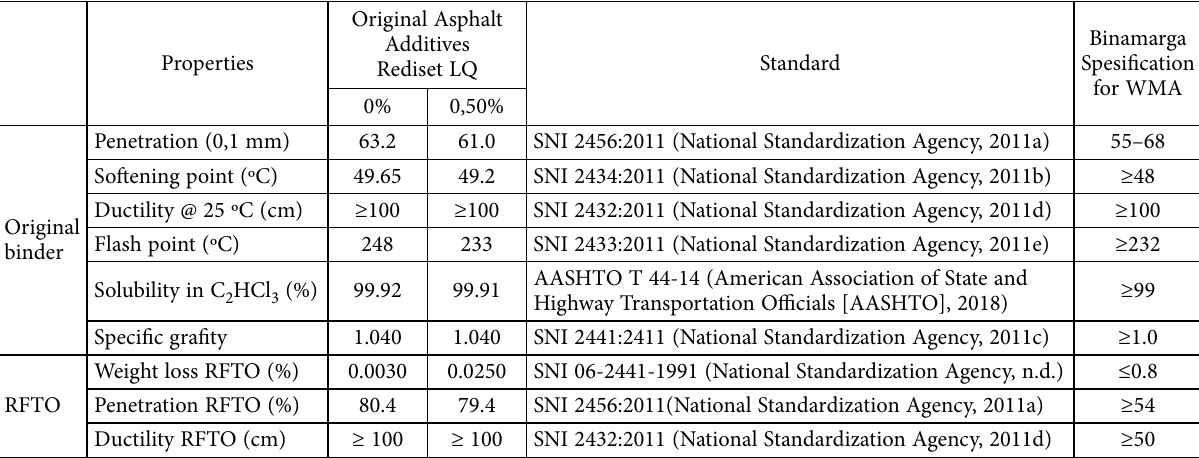
Table 2. Original asphalt aditif Rediset LQ